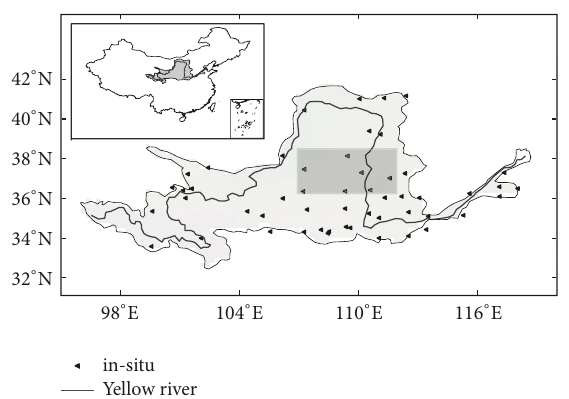
Figure 1: The study area of Yellow River basin and the locations of agrometeorological stations. A typical area for validation is marked in grey square. The triangles represent the agrometeorological